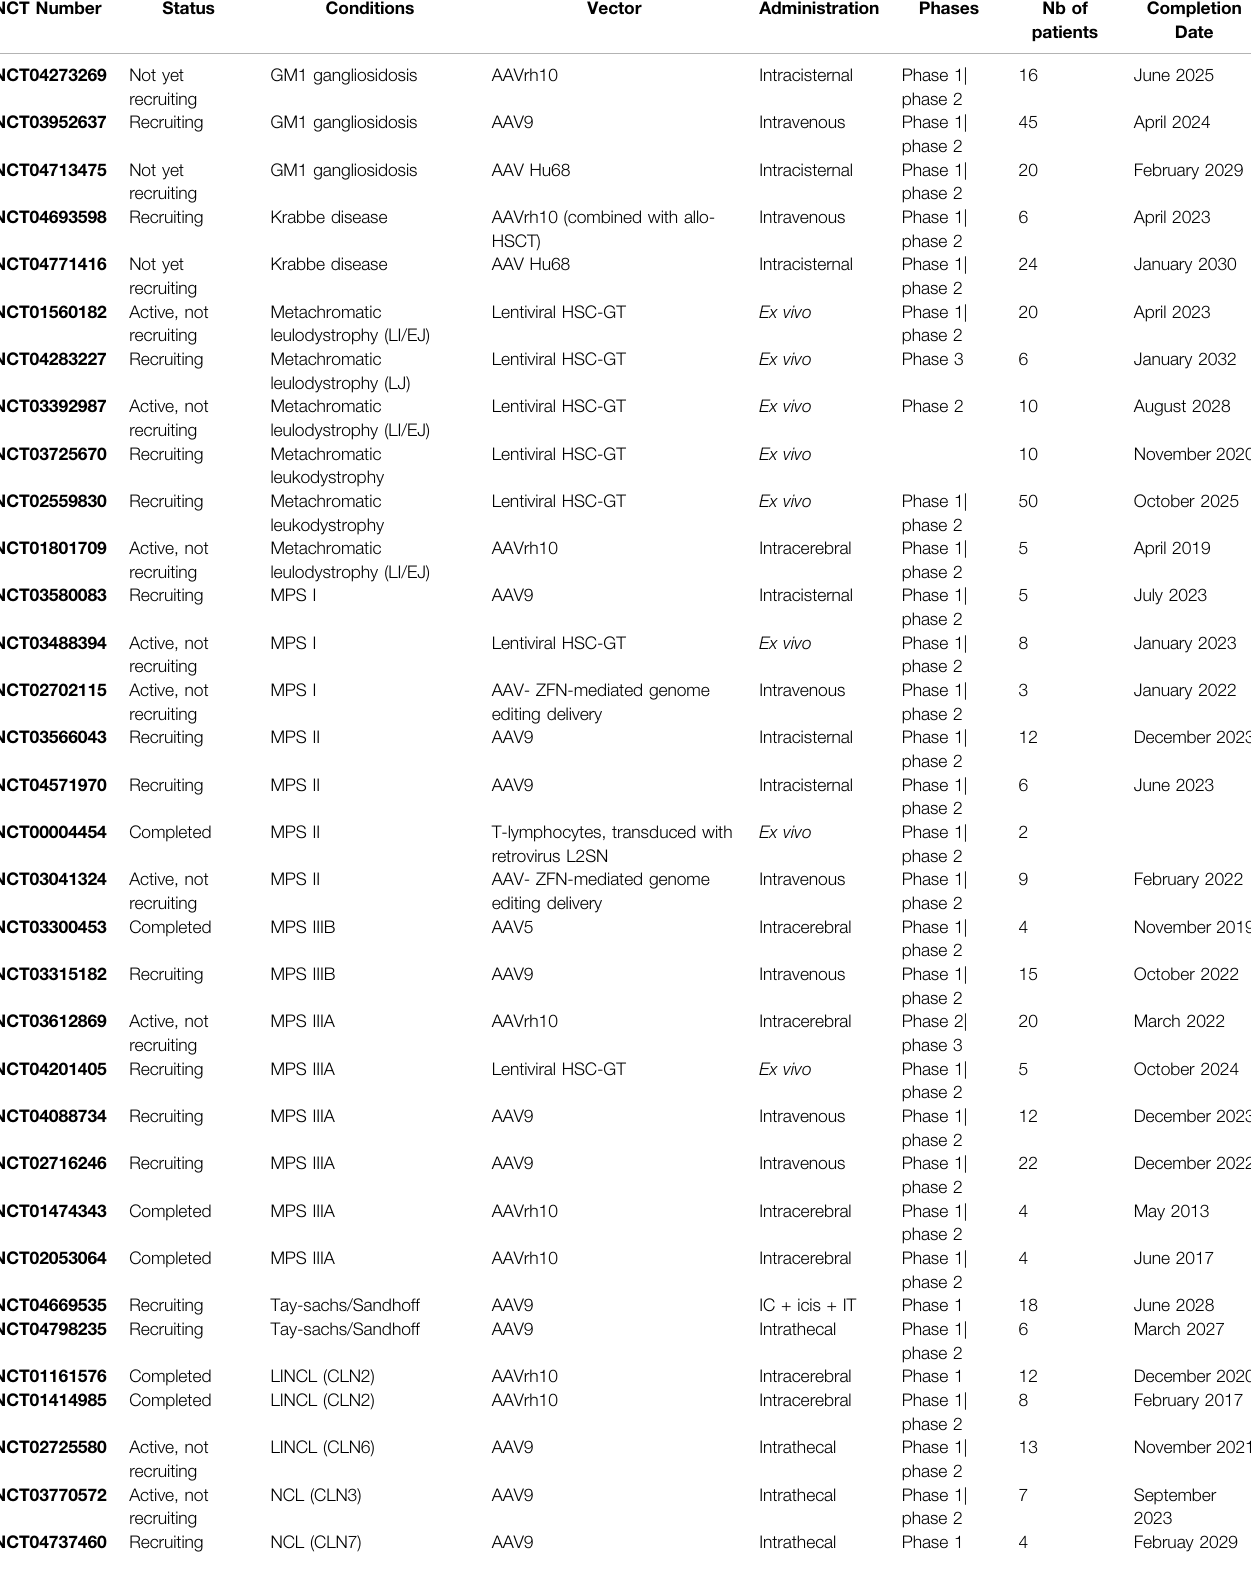
TABLE 1 | Completed or ongoing viral vector gene therapy-based clinical trialsfor lysosomalstoragedisorders with CNS involvement. Data from clinicaltrials.gov as ofJune